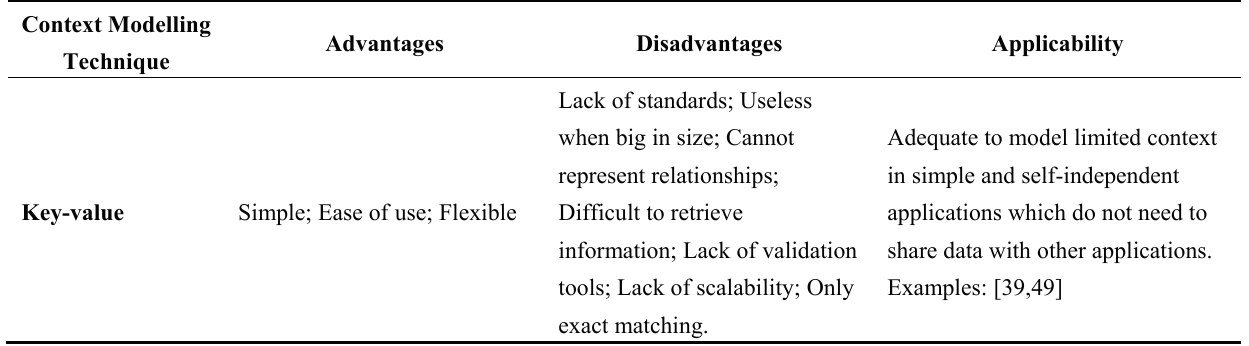
Table 3. Comparison of existing context modelling